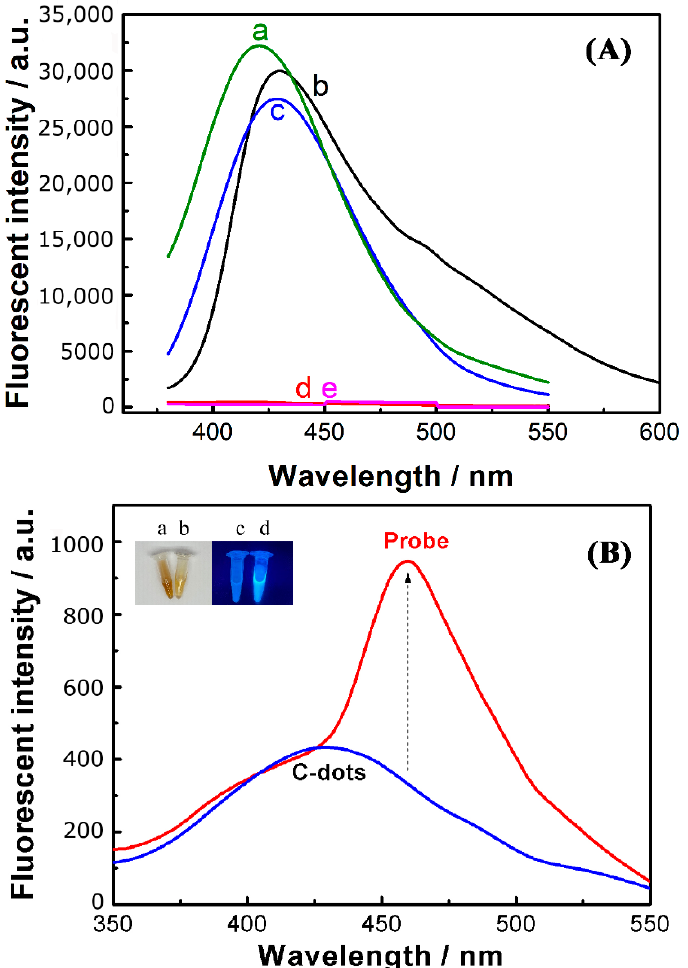
Figure 1. Fluorescence of C-dots synthesized using difference reagents ( A ). 3-hydroxyphenylboric acid (curve a); 3-aminophenylboric acid (curve b); 4-formylphenylboronic acid (curve c); 4-mercaptophenylboronic acid (curve d); 4-vinyl phenylboronic acid (curve e). Fluorescence spectra of C-dots using 3-hydroxyphenylboric acid and dopamine-functionalized fluorescent C-dots (probe) ( B ). The inserted two photos show the color of C-dots (a) and dopamine-functionalized fluorescent C-dots (b) solutions. λ ex : 285 nm. The other two inserted photos show fluorescence color of C-dots (c) and dopamine-functionalized fluorescent C-dots (d) solutions under 365 nm ultraviolet light. As shown in Figure 1B, the synthesized C-dots have a dark brown transparent solution and emit blue fluorescence under 365 nm ultraviolet light (the inserted photos). The syn- thesized C-dots have maximal fluorescence emission at 420 nm. After C-dots modification with dopamine, dopamine-functionalized C-dots as the ratiometric fluorescence probe are changed from dark brown to brown yellow transparent solution (the inserted photos). More- over, fluorescence of dopamine-functionalized C-dots gets significantly stronger than that of C-dots. More importantly, dopamine-functionalized C-dots have two fluorescence emission peaks at 420 nm and 460 nm at maximal excitation wavelength of 285 nm (Figure 2A) with fluorescence quantum yield (QY) of 28.4%. Moreover, dopamine-functionalized C-dots can be stable within two months by monitoring the fluorescent intensity, which suggests their good photostability (Figure 3). From TEM images (Figure 2B), it can be seen that dopamine-functionalized C-dots are nearly 1–2 nm, which is nearly the same as C-dots in most other reports [27]. It is utilized as fluorescent probe for ratiometric detection of ClO − in the following